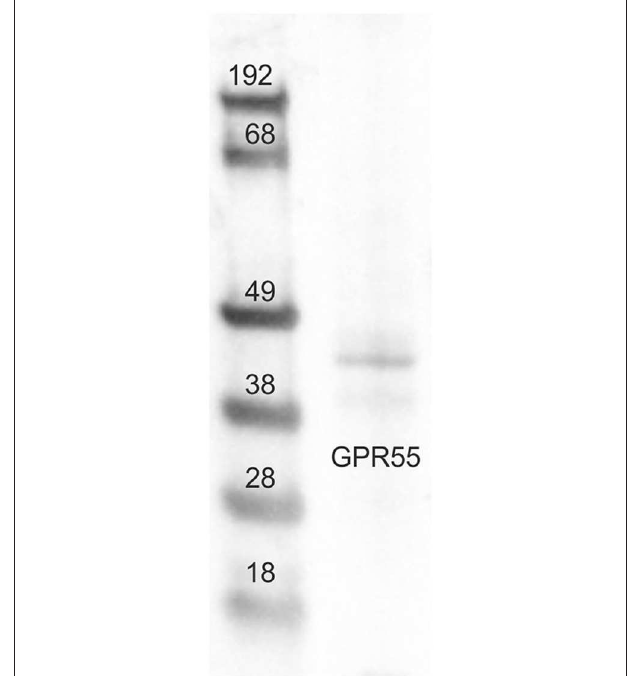
FIGURE 1 | Representative image of Western blots (WB) analysis showing the specificity of the primary antibody rabbit anti-G protein-coupled receptor 55 (GPR55). The antibody revealed a single band of expected molecular weight ( ∼ 40 kDa). The images of the different immunoblots were slightly adjusted in brightness and contrast to match their